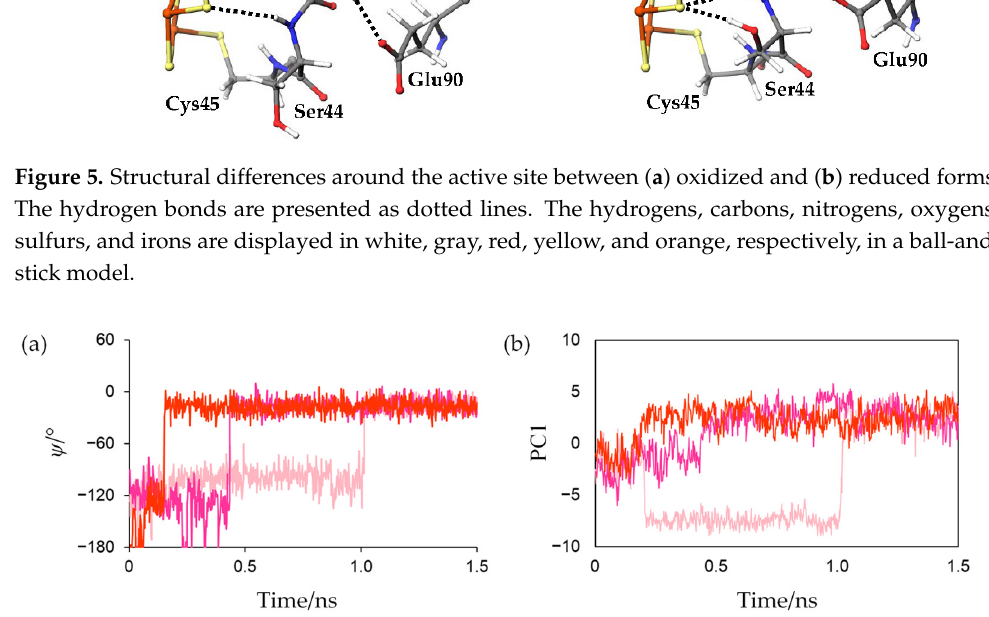
Figure 6. ( a ) Time courses of dihedral angle ψ characterizing the main-chain conformation of Cys42 in reduced forms and ( b ) time courses of PC1. Plots of the first, second, and third simulations are presented in light pink, magenta, and red, respectively.